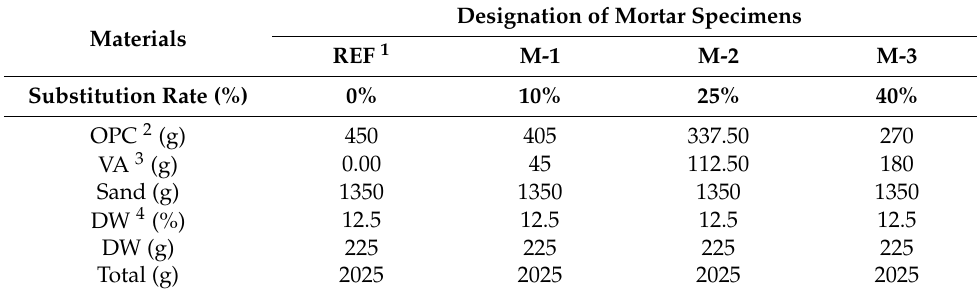
Table 1. Design of the dosages of the mortar specimens used in this study.